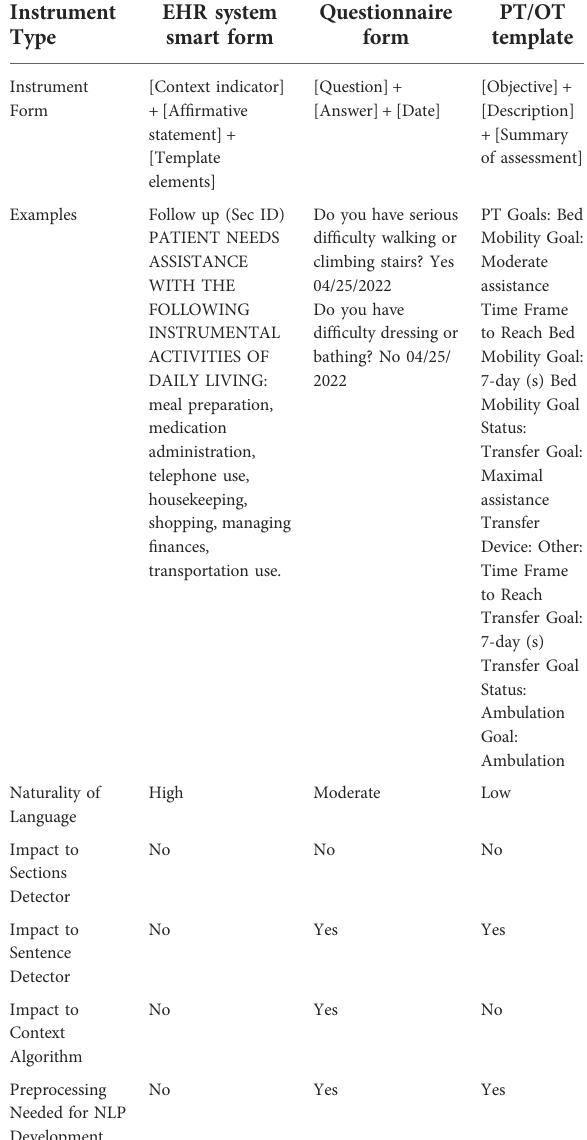
TABLE 2 Summary of instrument representations and implications for NLP development.